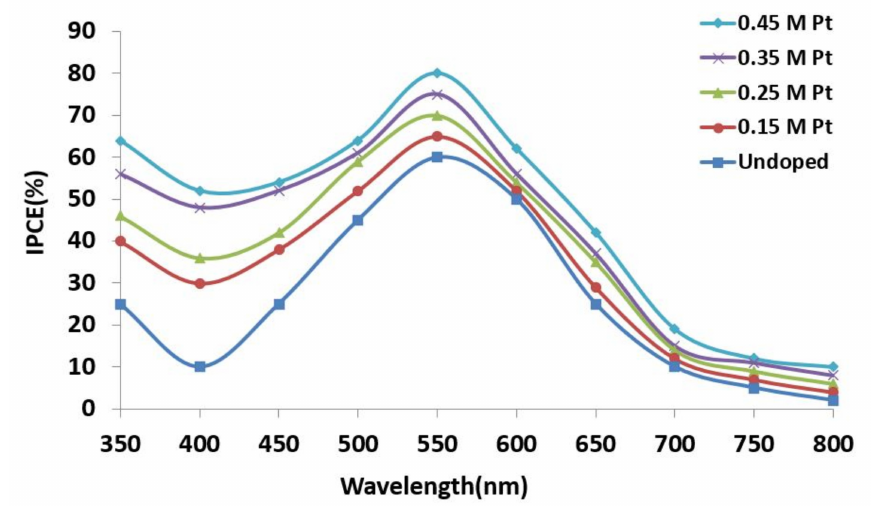
Figure 10. IPCE spectra of undoped and Pt-doped TiO 2 at different molar concentrations.